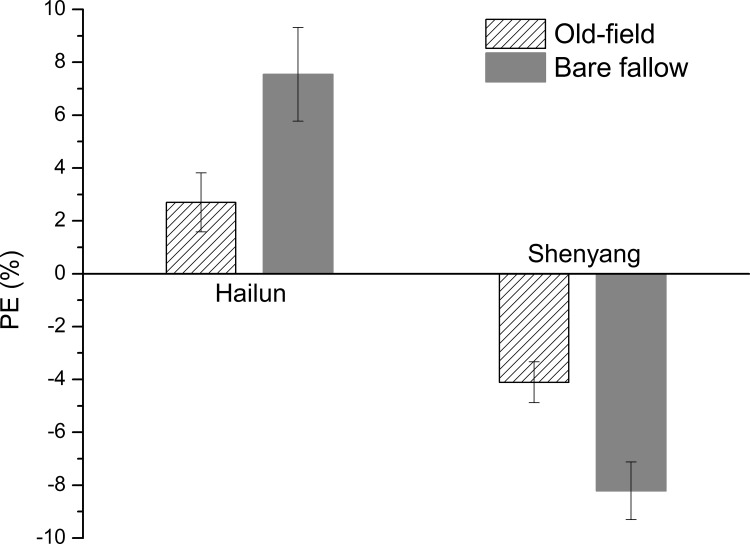
The relative priming effect (PE%, PE% = [(α × Qsample – Qcontrol) / Qcontrol] × 100, where Q is the CO2 respired from sample or control, and α is the percentage of SOC-derived CO2 to total respiration (%) of old-field and bare fallow soils from Hailun and Shenyang Station after 815 days incubation.Error bars show ±1 SE.